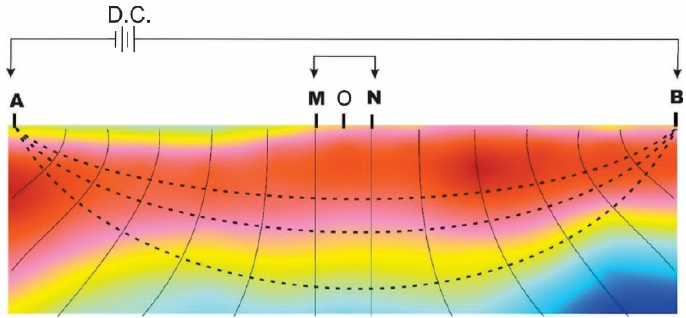
Figure 3. Tetraelectrodic device with Schlumberger setting diagram used.